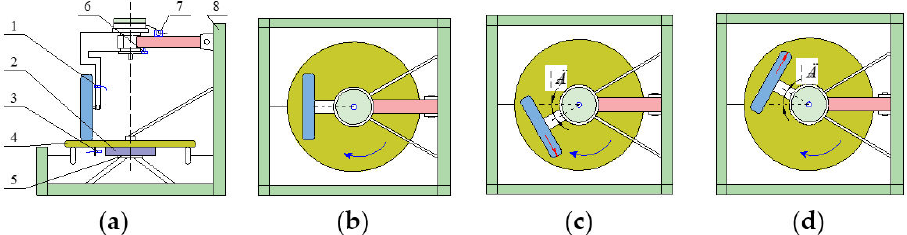
Figure 4. Motion diagram of the off-center steering mechanism on the steering test bench: ( a ) com- position of the test bench (front view); ( b ) initial position (vertical view); ( c ) steering of acceleration form; ( d ) steering of deceleration form. 1. Rotation speed sensor; 2. support tray; 3. rotation speed sensor; 4. horizontal turntable; 5. driving motor of horizontal turntable; 6. angular transducer; 7. current sensor of the EFL; 8. bench frame. Note: The red arrow is the initial forward direction of the wheel, and the blue arrow is the rotation direction of the horizontal turntable. δ sf and δ sr are the steering angle of the left front wheel and right front wheel,